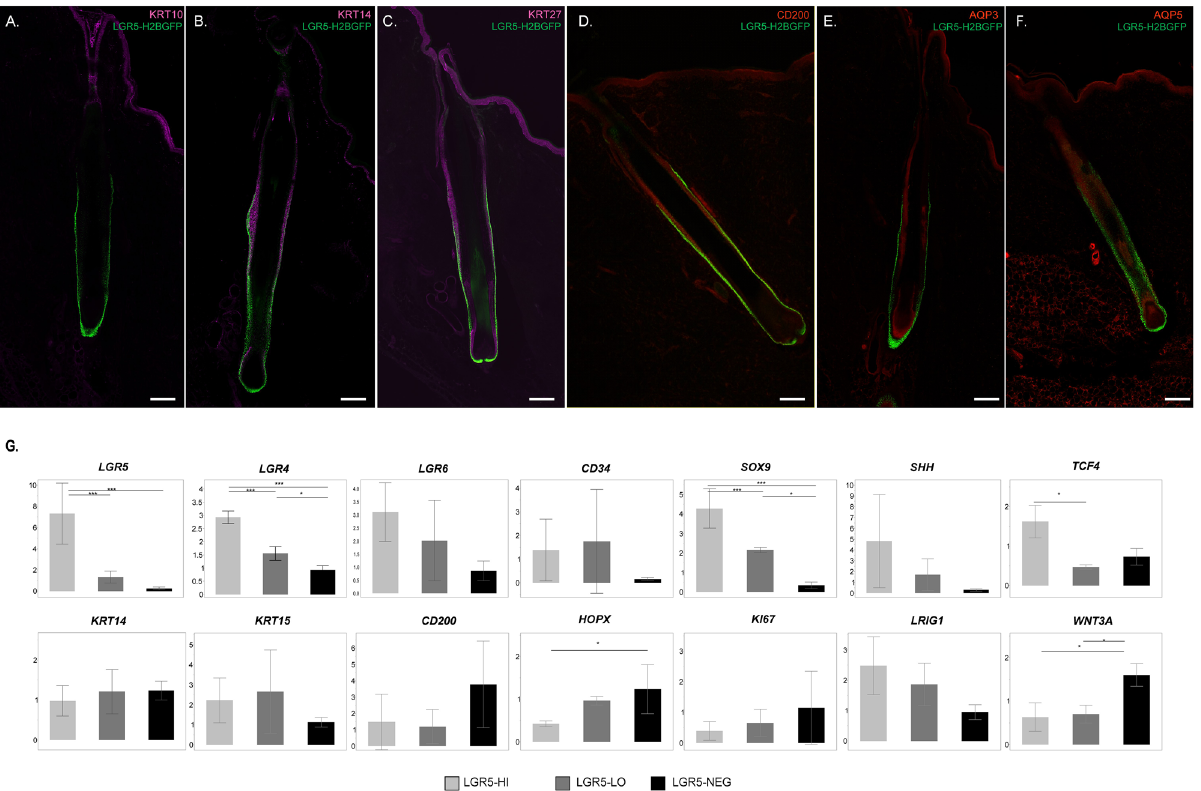
Figure 3. LGR5-H2BGFP epidermal cells express known stem cell and epidermal markers. Confocal microscopy images of hair follicles following antibody staining with anti-GFP and known skin markers and overlaid with DAPI. ( A ) Keratin 10 (KRT10), ( B ) Keratin 14 (KRT14), ( C ) Keratin 27 (KRT27), ( D ) CD200, ( E ) Aquaporin 3 (AQP3), ( F ) Aquaporin 5 (AQP5). Scale bar represents 200 μM. ( G ) Relative expression of known stem cell markers based on delta-delta Ct analysis of RT-qPCR from LGR5-H2BGFP-high (LGR5-HI, light gray), LGR5-H2BGFP-low (LGR5-LO, dark gray), or LGR5-H2BGFP negative (LGR5-NEG, black) populations after flow sorting. Each sample is normalized to ACTB and GAPDH and then to unsorted epidermis, n = 3 pigs. ANOVA followed by Tukey’s honestly significant difference (HDS) test ***P < 0.005, *P < 0.05, error bars indicate standard